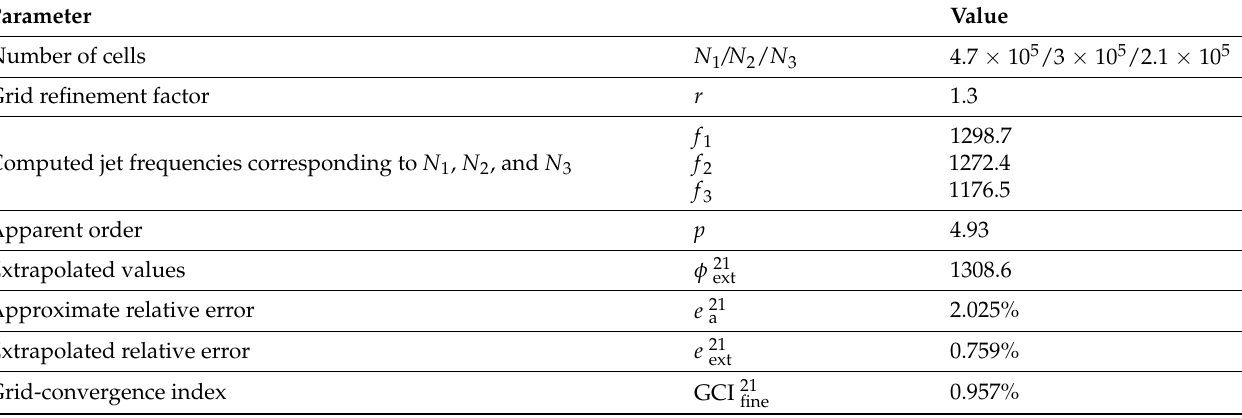
Table 2. Grid-convergence index (GCI) analysis for the internal domain of a fluidic oscillator.